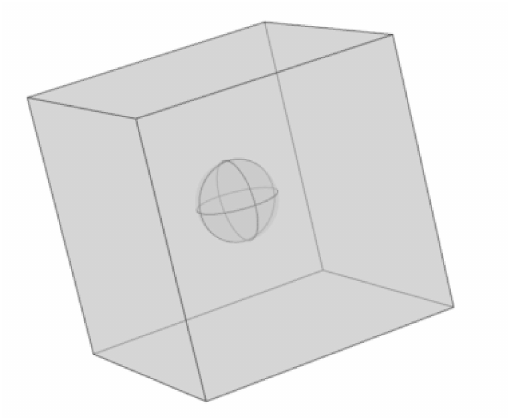
Figure 11. Numerical simulation model of bubble rising in liquid nitrogen.